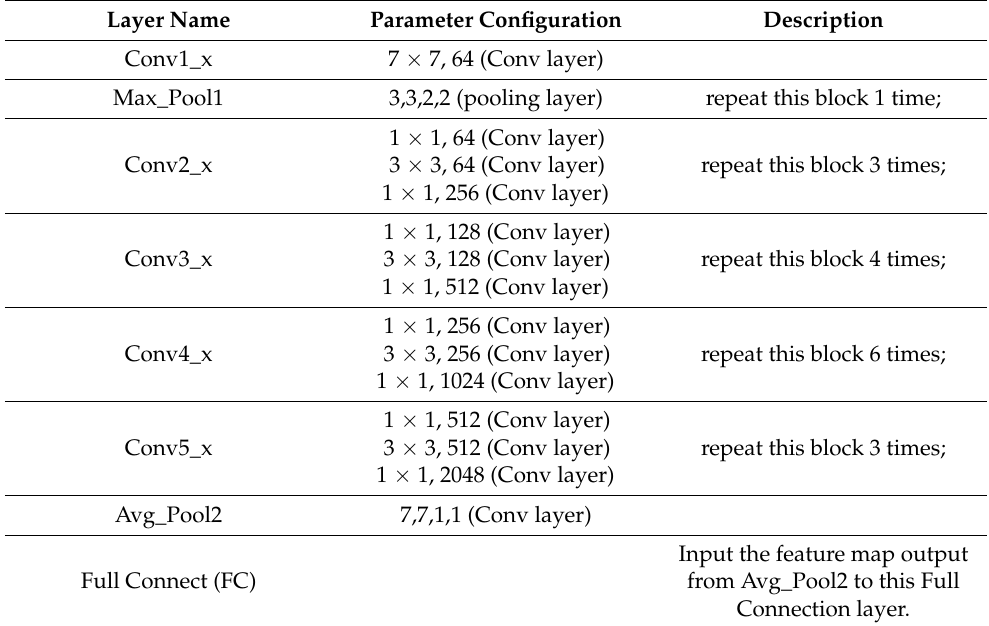
Table 5. The specific parameter setting of convolution layer and pooling layer in ResNet embedded in SENet